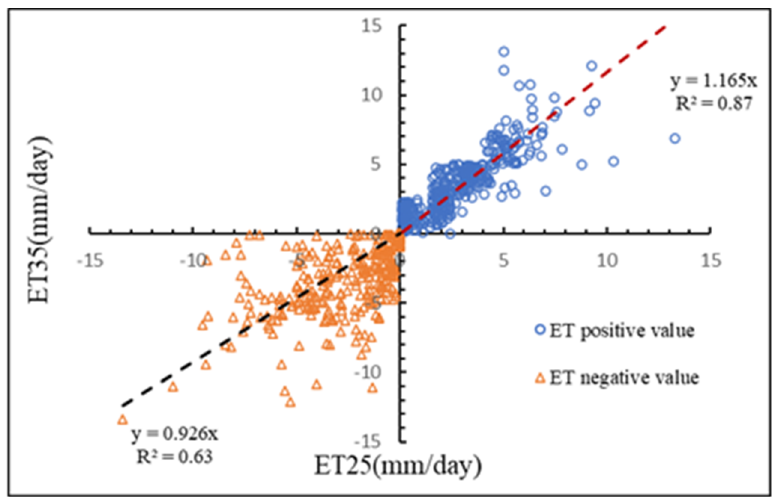
Figure 4. Daily comparison of daily evapotranspiration by the two − layer EC.